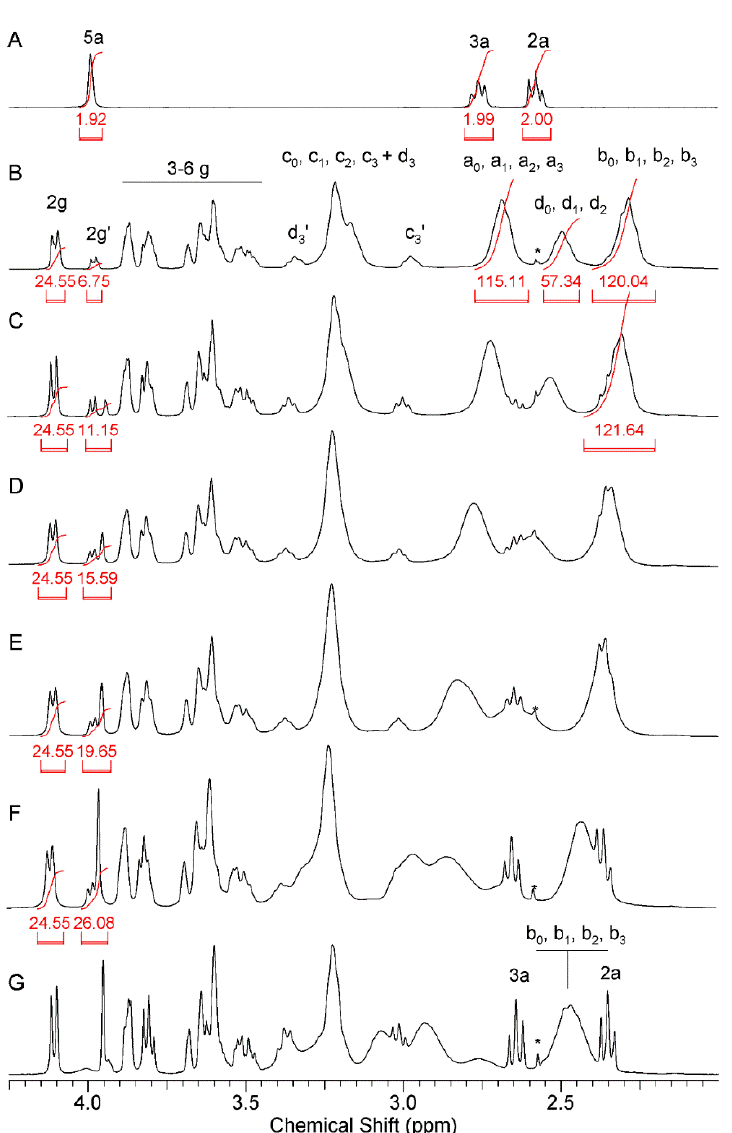
Figure 2. The 1 H NMR spectra of ( A ) 5-aminolevulinic acid (ALA) in D 2 O; ( B ) G3 32gh (5.1 mM in D 2 O); ( C – F ) G3 32gh (5.1 mM in D 2 O) containing 2.2 ( C ), 4.4 ( D ), 6.5 ( E ), 9.7 ( F ), and 15 ( G ) equivalents of ALA. Final concentration of ALA in case of solution F was 76 mM, which is twice compared to ALA concentration in saturated aqueous solution. The residual DMSO resonance is labeled with asterisk.